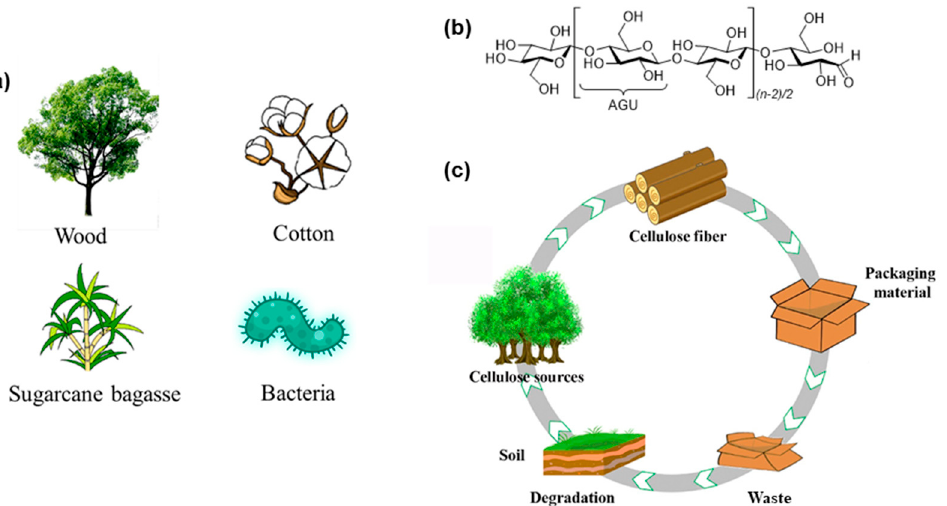
Figure 1. ( a ) Common sources of cellulose; ( b ) Chemical structure of cellulose; ( c ) Life cycle of cellulosic food packaging [15] .